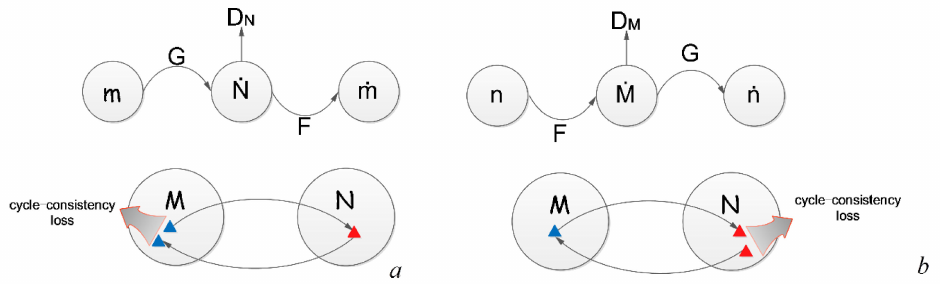
Figure 3. ( a ) Forward and ( b ) backward consistency